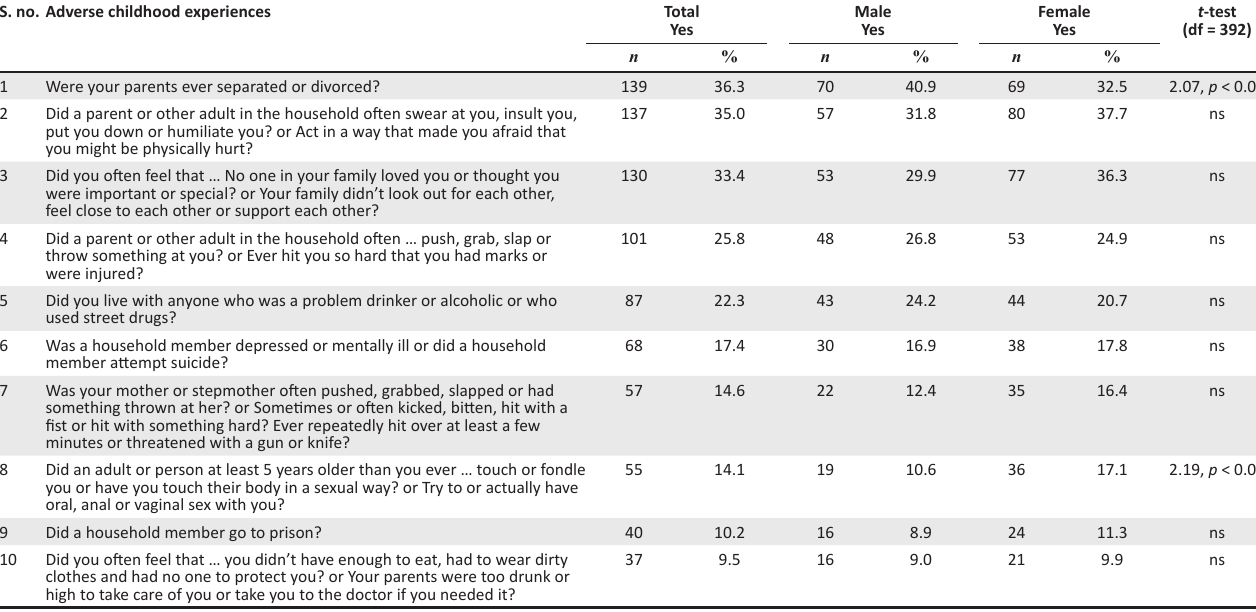
TABLE 2: Reporting adverse childhood experiences stratified by gender ( N =